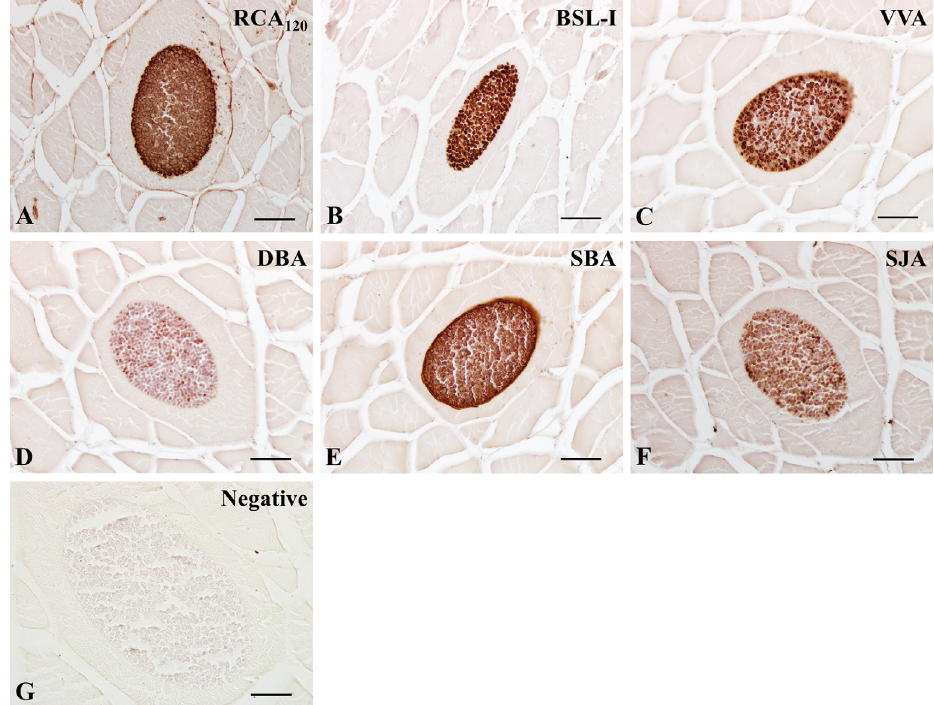
Figure 3. Lectin histochemical findings of galactose/N-acetylgalactosamine in Kudoa septempunctata -infected muscles. A, RCA120; B, BSL-I; C, VVA; D, DBA; E, SBA; F, SJA; G, Negative control (DBA preabsorbed with 0.2 M GalNAc). Scale bars in (A)–(G) represent 20 l